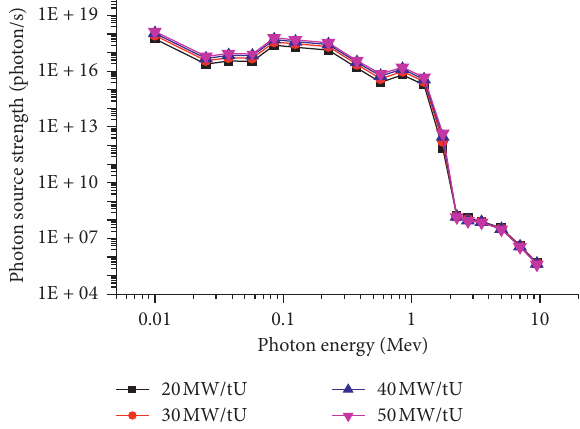
Figure 6: The photon source strengths under different specific powers.